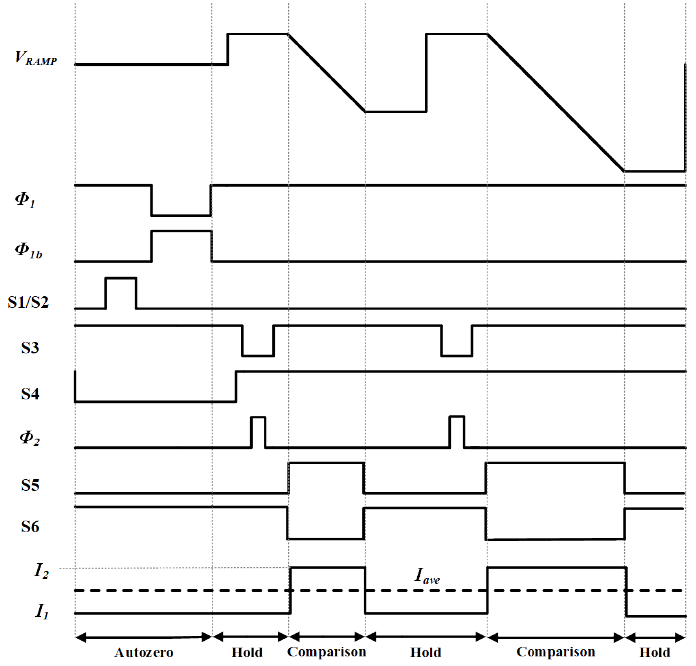
Figure 10. Timing diagram of the control signal of the